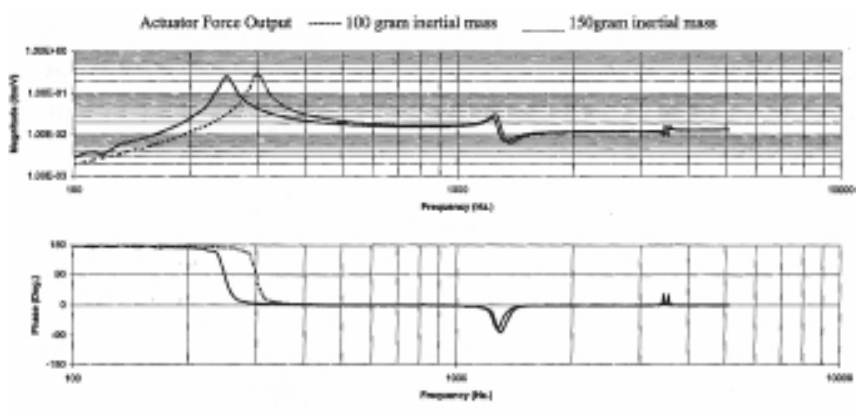
Fig. 6. Piezoelectric actuator PCB Piezotronic Model